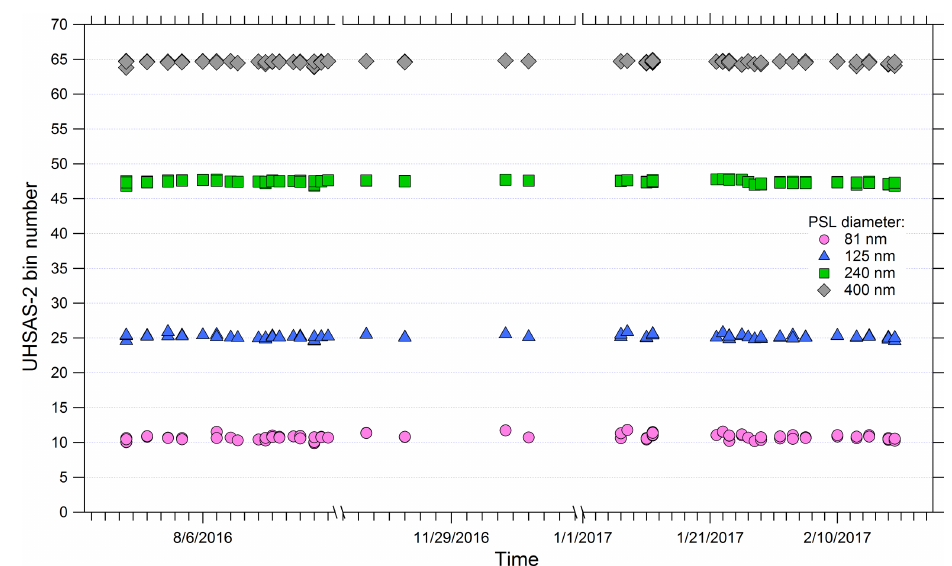
Figure 9. Fitted peak bin number for four PSL size standards and as a function of time from July 2016 to February 2017, showing calibration precision and the stability of the UHSAS-2 sizing during ATom-1 and